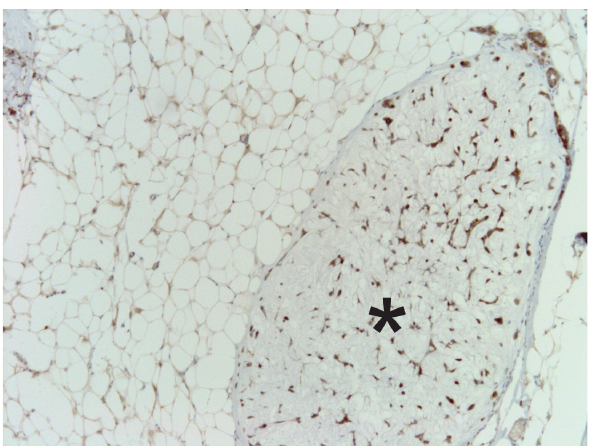
Fig. 5. Box&whiskers graph of histoscore in recurrent and non-recurrent primary tumours. Histoscore in mesenchymal cells of primary and recurrent pleomorphic adenomas shows a significant difference between the PrimToRec group and the first recurrence group